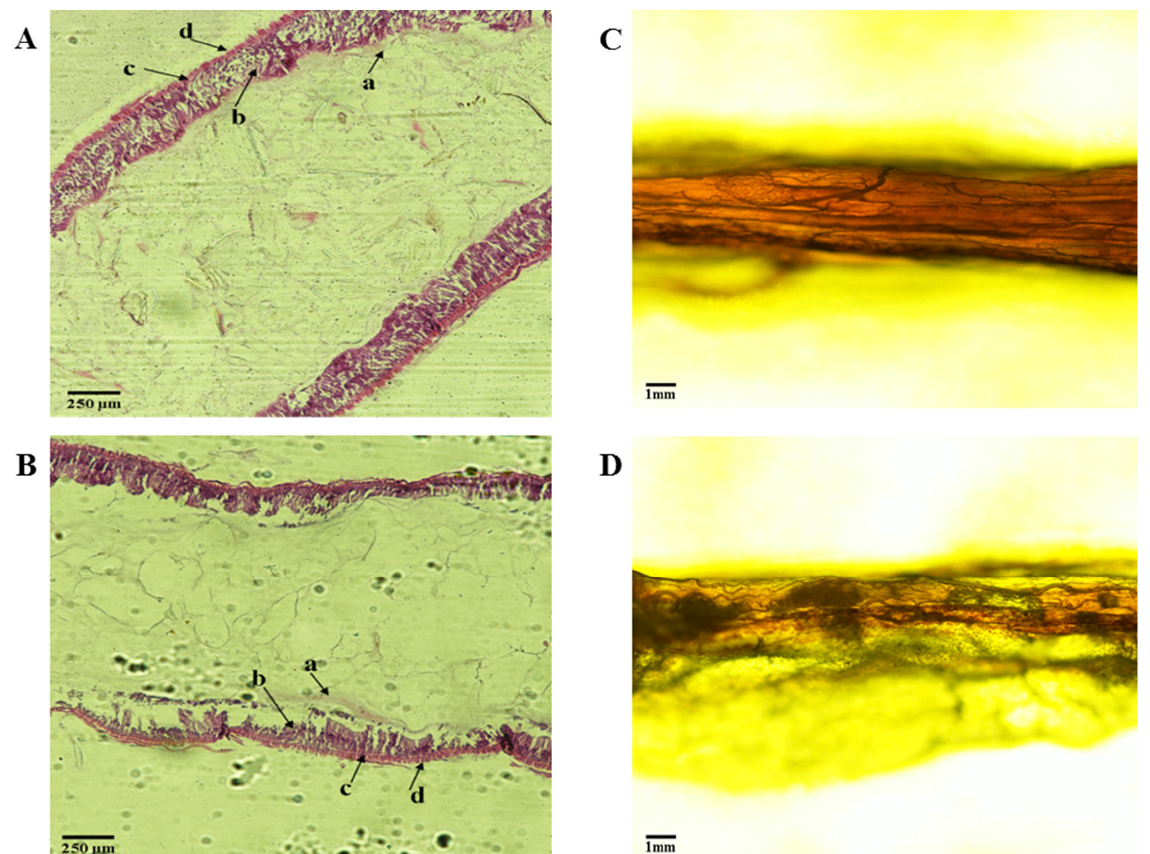
Figure 3. Paraffin tissue in the midgut of T. molitor larva (HE staining), including mealworms fed with wheat bran only ( A ) and mealworms fed with PS only ( B ). a: peritrophic membrane; b: enterocytes; c: circular muscle; d: longitudinal muscle. ( C ). Midgut morphology of T. molitor larvae fed wheat bran. ( D ). Midgut morphology of T. molitor larvae fed with PS.